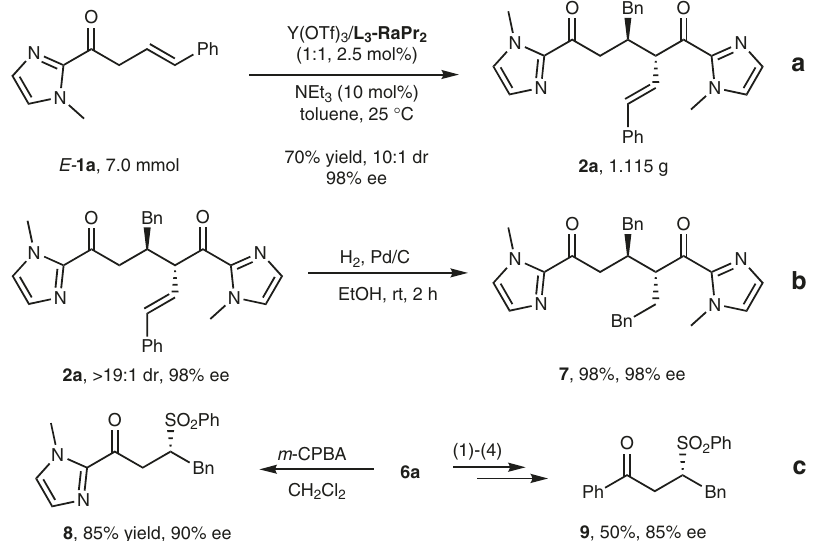
Fig. 6 Gram-scale synthesis and derivatization of products. a Gram-scale synthesis of 2a . b Hydrogenation of 2a . c The derivatization of 6a , (1) PhMgBr, THF; (2) MeOTf, MeCN; (3) K 2 CO 3 (aq); (4) m -CPBA, CH 2 Cl 2